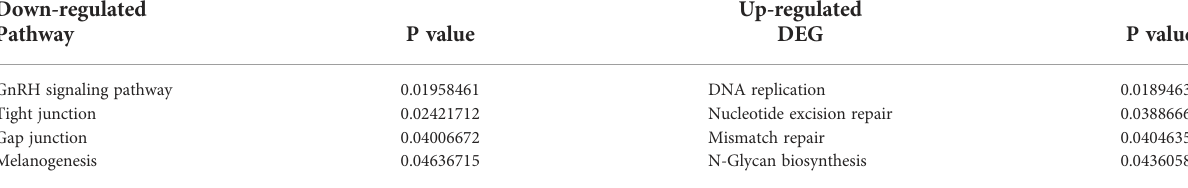
TABLE 3 Up-regulated and down-regulated pathways.